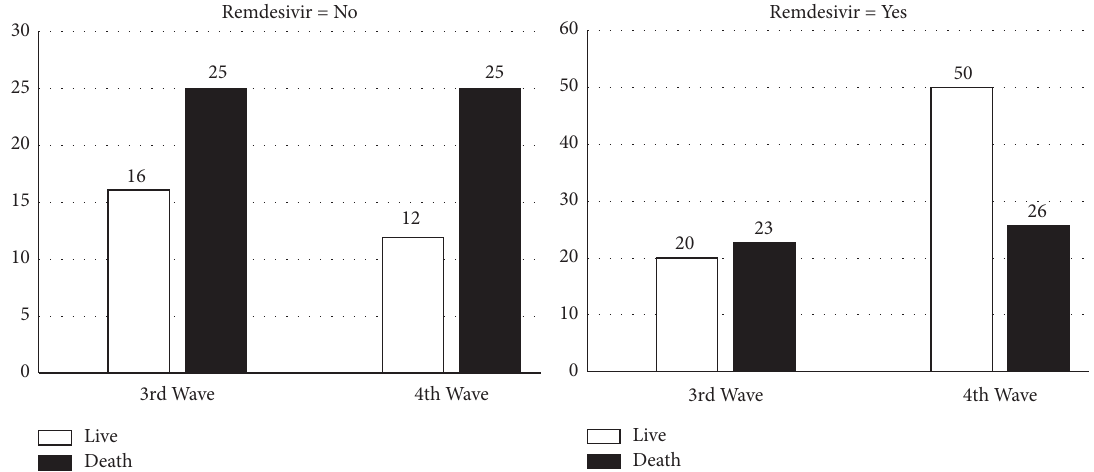
Figure 1: Outcome of remdesivir treatments among third and fourth wave COVID-19 cases during